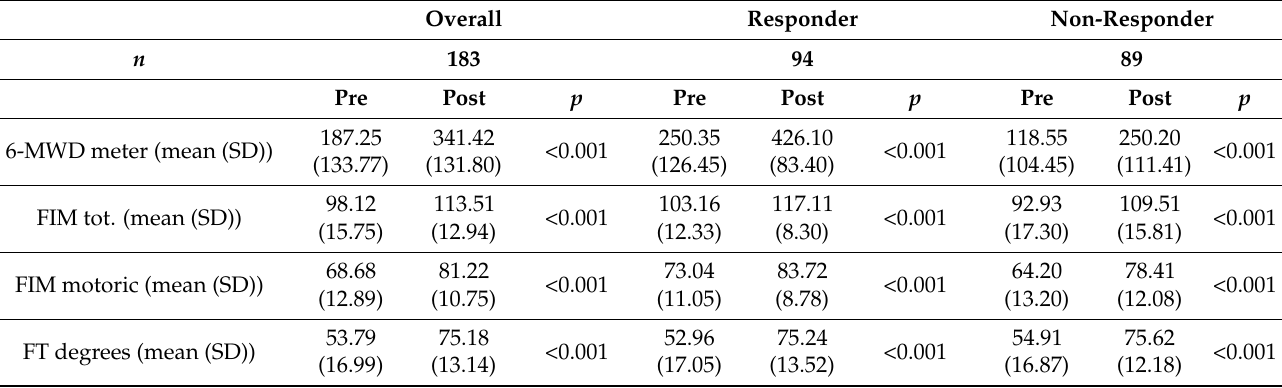
Table 4. Pre-post comparison between responders and non-responders according to 6MWD, FIM tot, FIM motoric, and FT.